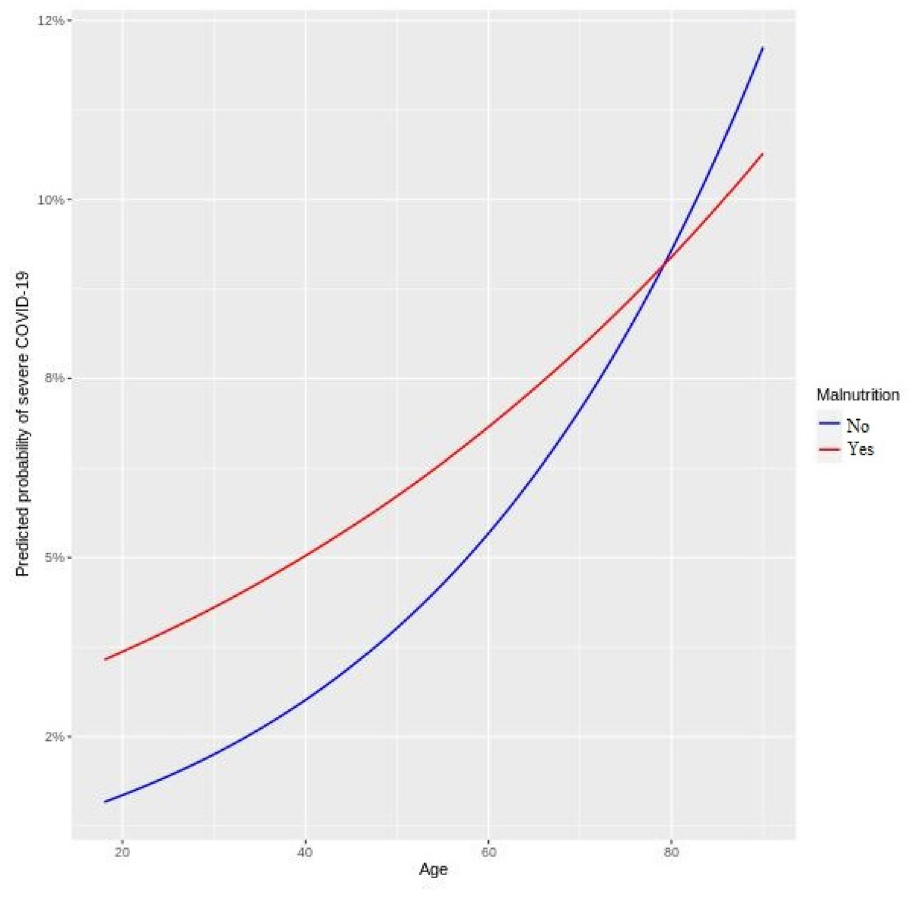
Figure 2. COVID-19 severity and interaction between malnutrition and age in